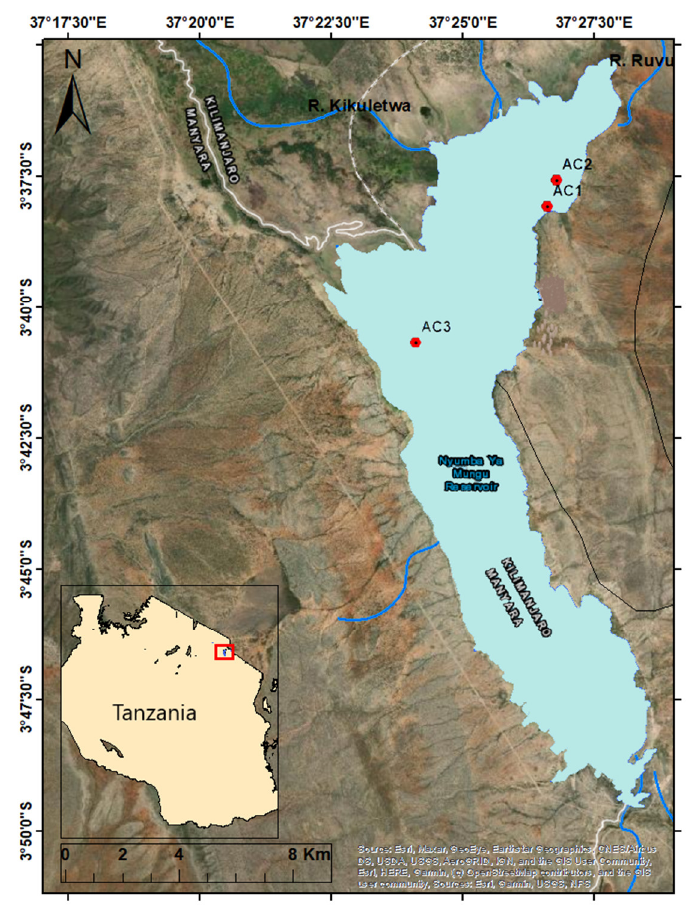
Figure 2. Sediment cores sampling locations (red